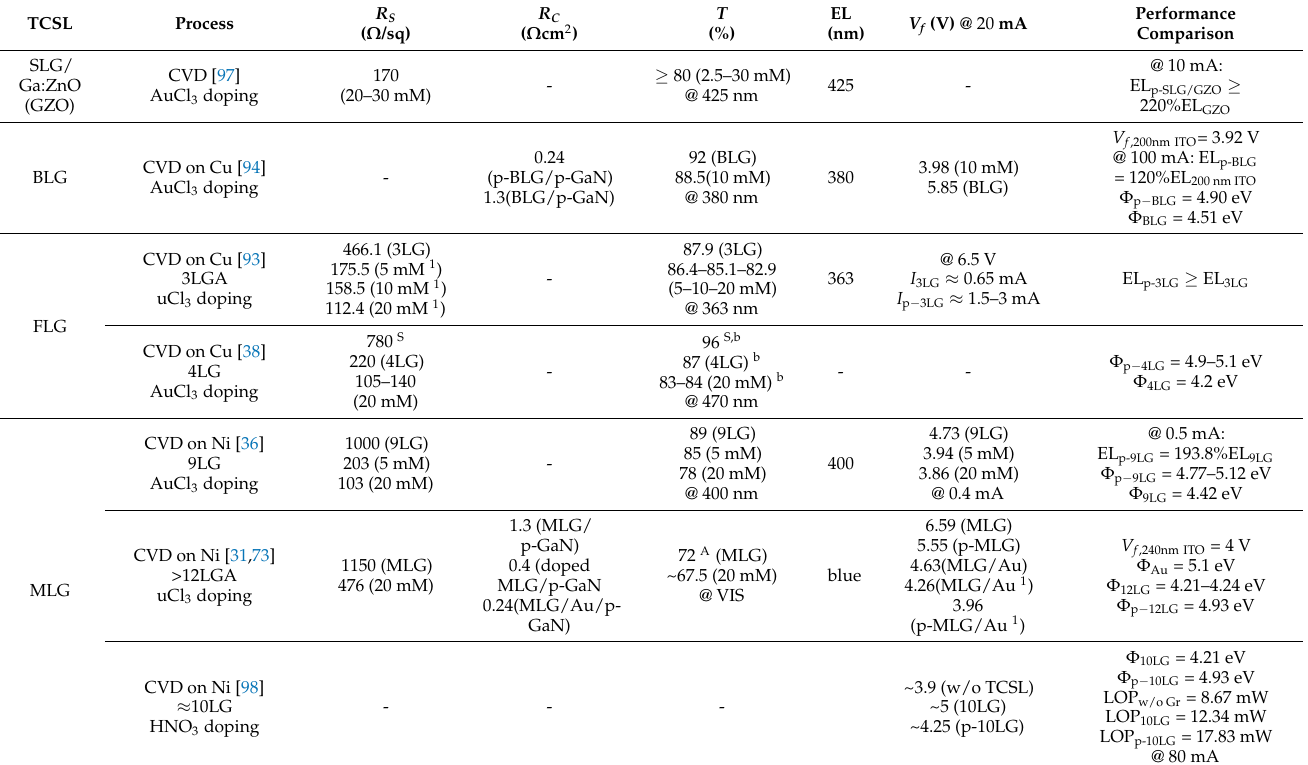
Table 5. Usage of p-type doped graphene (p-Gr) as TCSL in GaN-based LEDs. The doping concentra- tion is given in